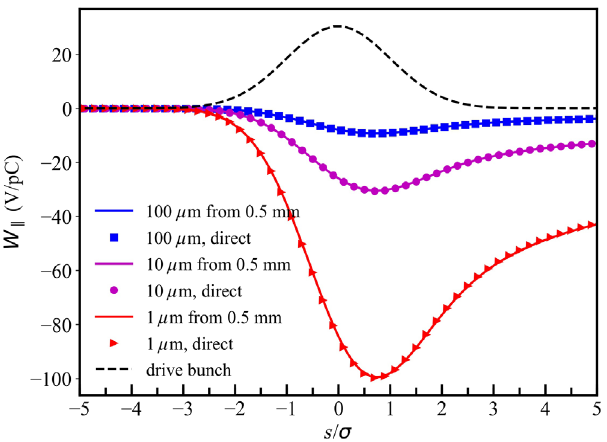
FIG. 5. Comparison of the reconstructed longitudinal wake potentials (solid lines) with direct ECHO simulations (symbols) performed at several rms bunch lengths, as indicated in the legend.